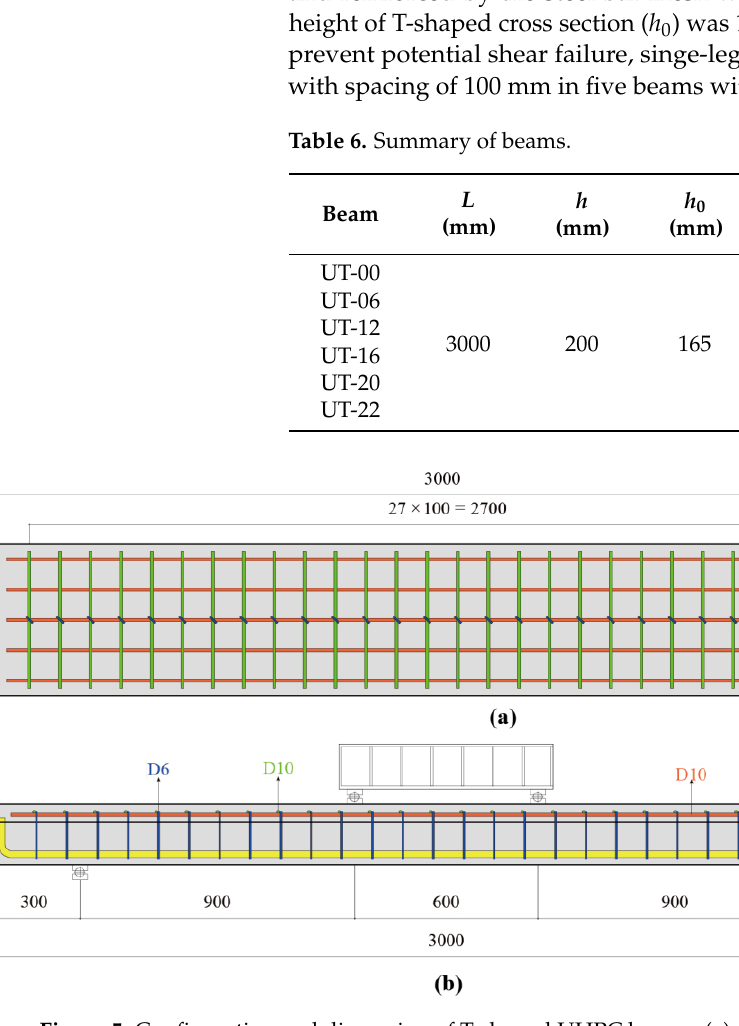
Figure 5. Configuration and dimension of T-shaped UHPC beams. ( a ) plan of flanges; ( b ) elevation; ( c ) cross section.